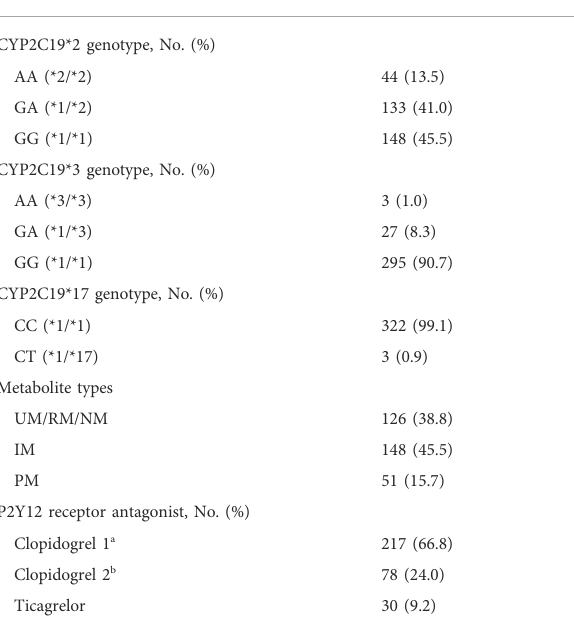
TABLE 2 Frequency distribution of genetic variants and selected a P2Y12 receptor antagonist.